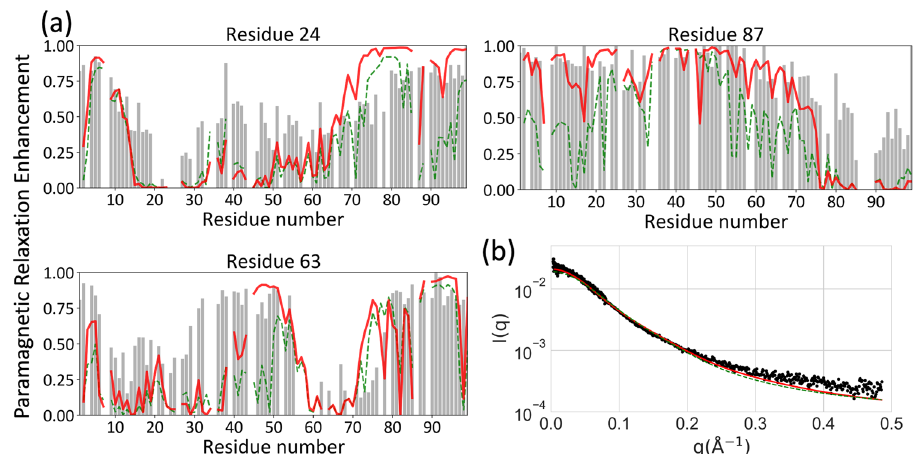
Fig. 3 Conformational characterization by PRE and SAXS. Comparison of experimental data and MD results for a PRE values with spin labels at residues 24, 63, and 87. b SAXS pro fi les. Experimental data are shown as gray bars or black dots; MD results are shown as green or red curves, calculated over all MD conformations, or excluding those with contacts between residues 1 – 42 and 73 – 99.